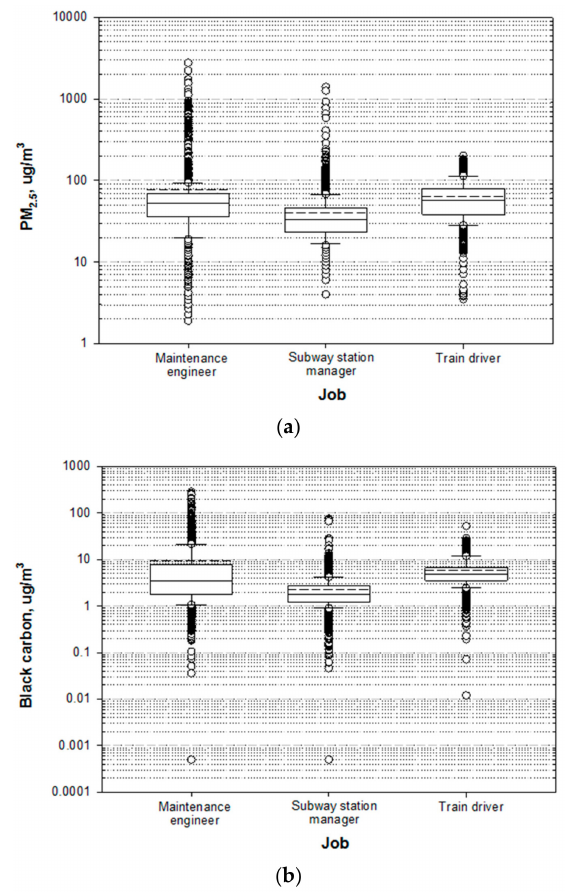
Figure 1. Distribution of ( a ) PM 2.5 and ( b ) black carbon exposure levels according to job. Dashed lines show the arithmetic mean. * p -values were obtained using the likelihood ratio test. ( a ) PM 2.5 ( p < 0.001 *); ( b ) black carbon ( p < 0.001